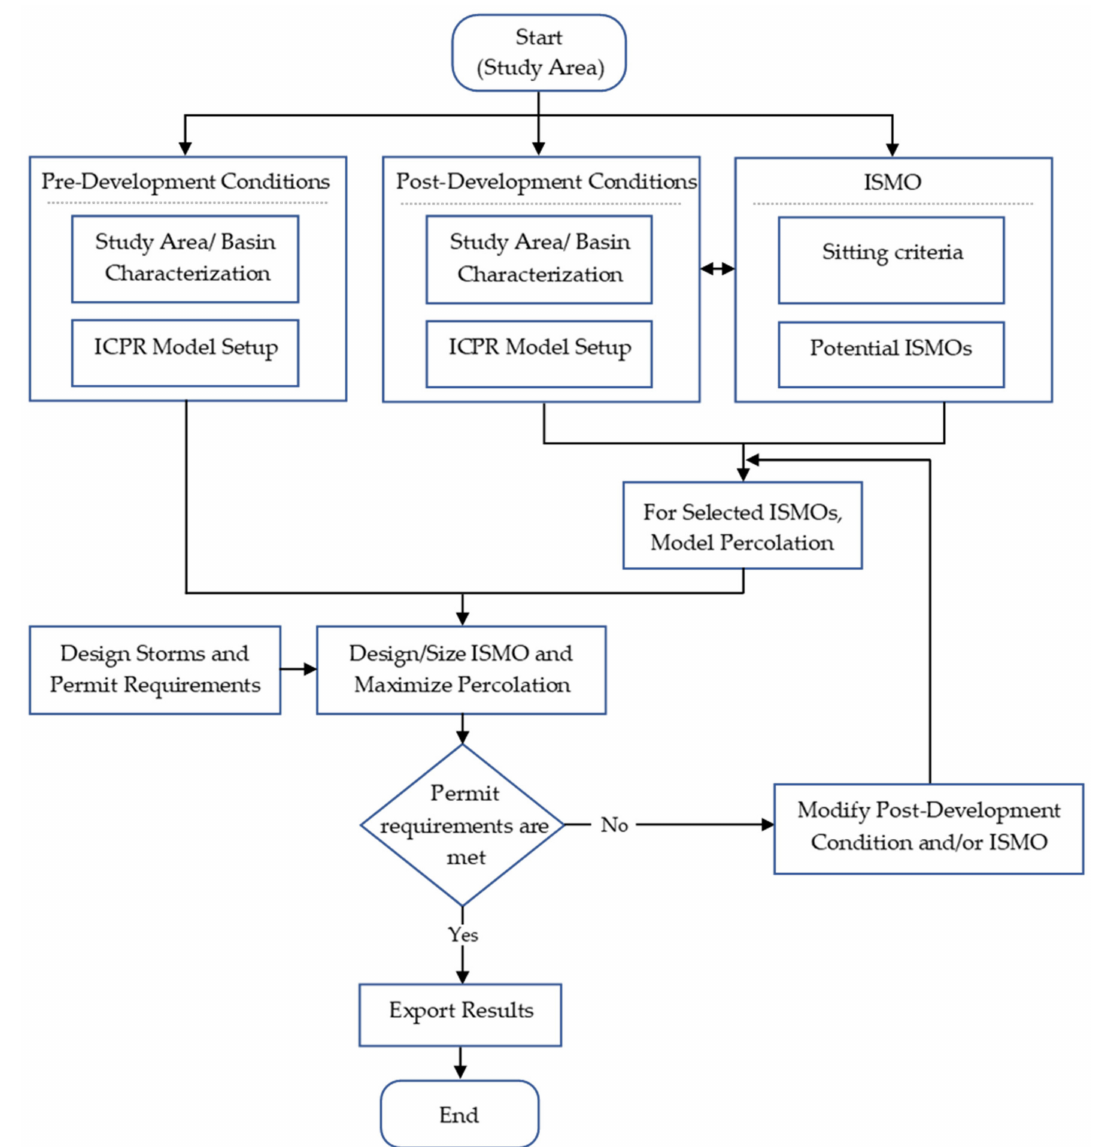
Figure 3. The proposed GIS- and ICPR-based approach for the design of ISMOs and estimation of